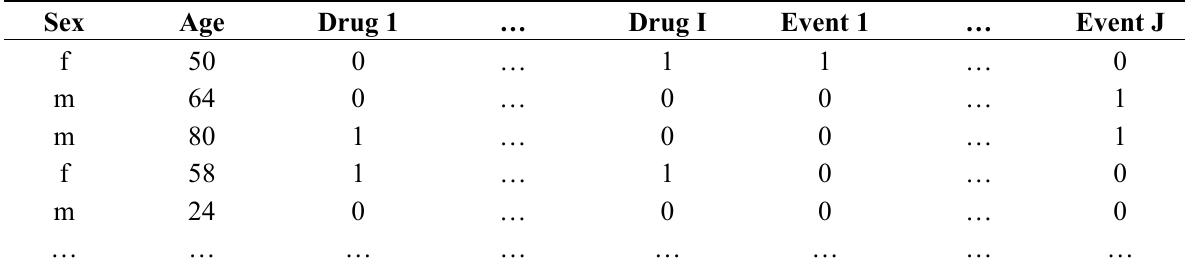
Table 3. Exemplary structure of “pseudo” spontaneous reporting data derived from longitudinal databases. Cells with “empty” reports on events or drug exposure, which would not be available in real spontaneous reports are highlighted (0 = no event/exposure reported, 1 = event/exposure reported).